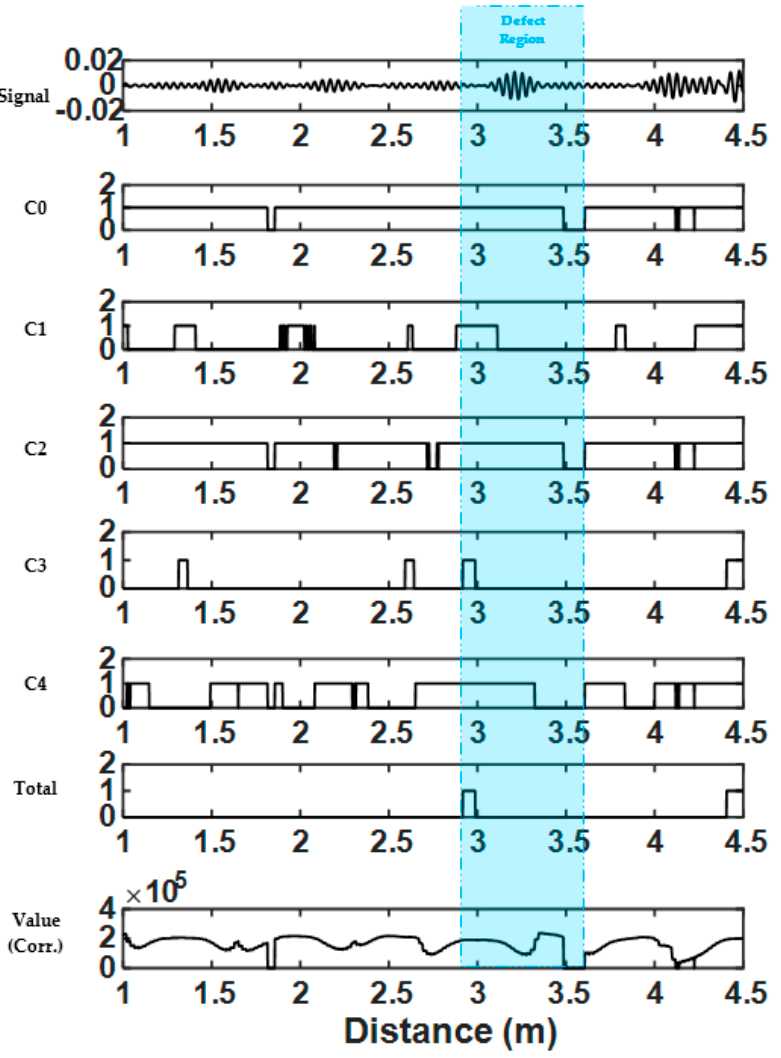
Figure 13. The generated results from the experimental pipe with a defect of 3% CSA and testing frequency of 38 kHz.